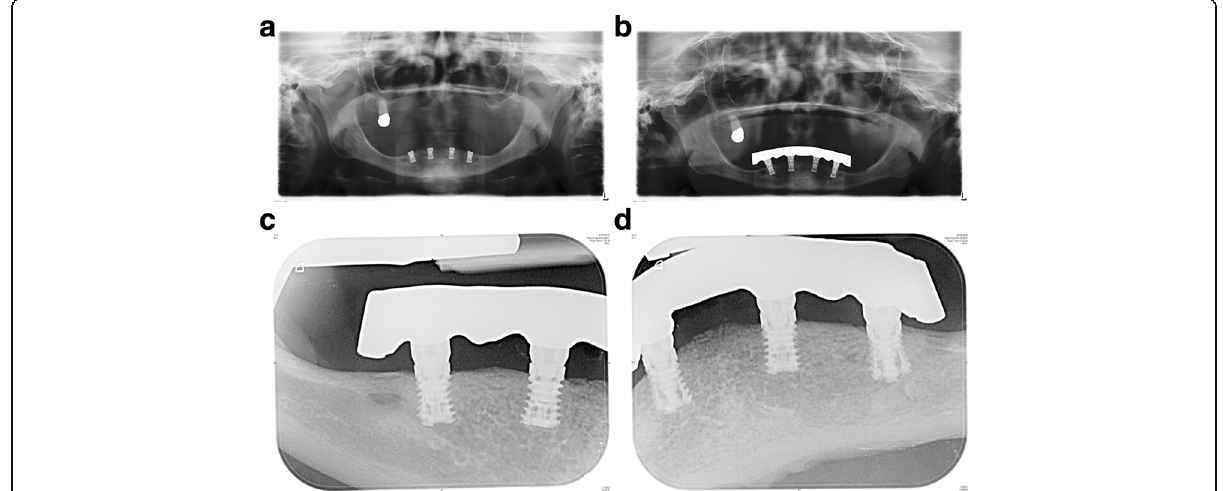
Fig. 5 a Postoperative orthopantomogram. b Follow-up orthopantomogram. c Follow-up standard periapical radiogram (implants i42 and i44). d Follow-up standard periapical radiogram (implants i32 and